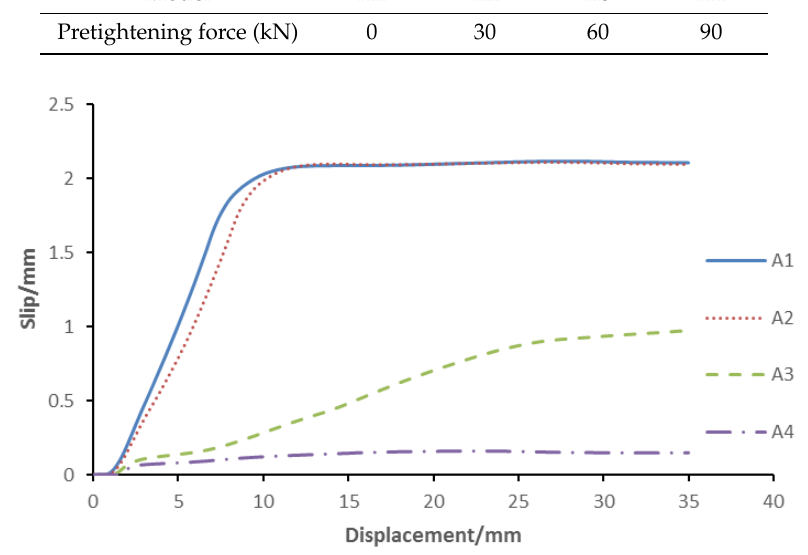
Figure 19. Slip-displacement curves.